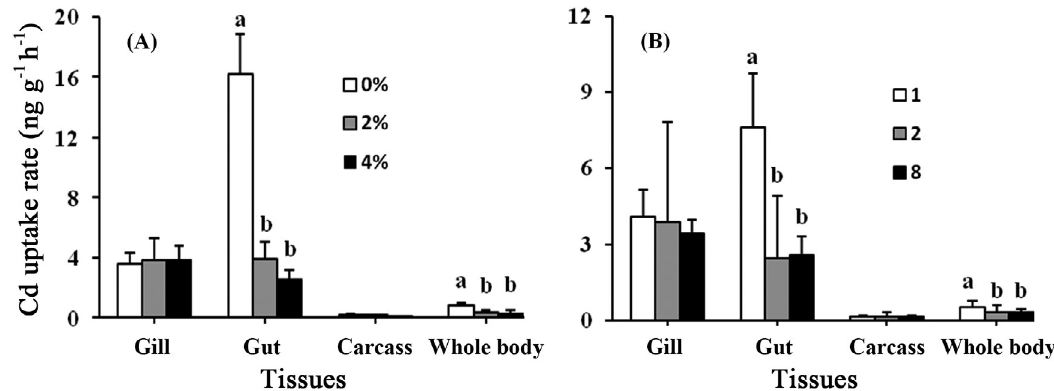
Fig. 2. Uptake rate (ng g –1 h –1 ) of waterborne Cd in various tissues of black sea bream Acanthopagrus schlegeli at 3 different feeding ratios or frequencies. Experimental treatments and statistical significance as in Fig. 1